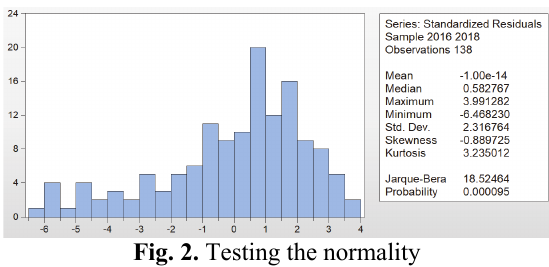
Fig. 2. Testing the